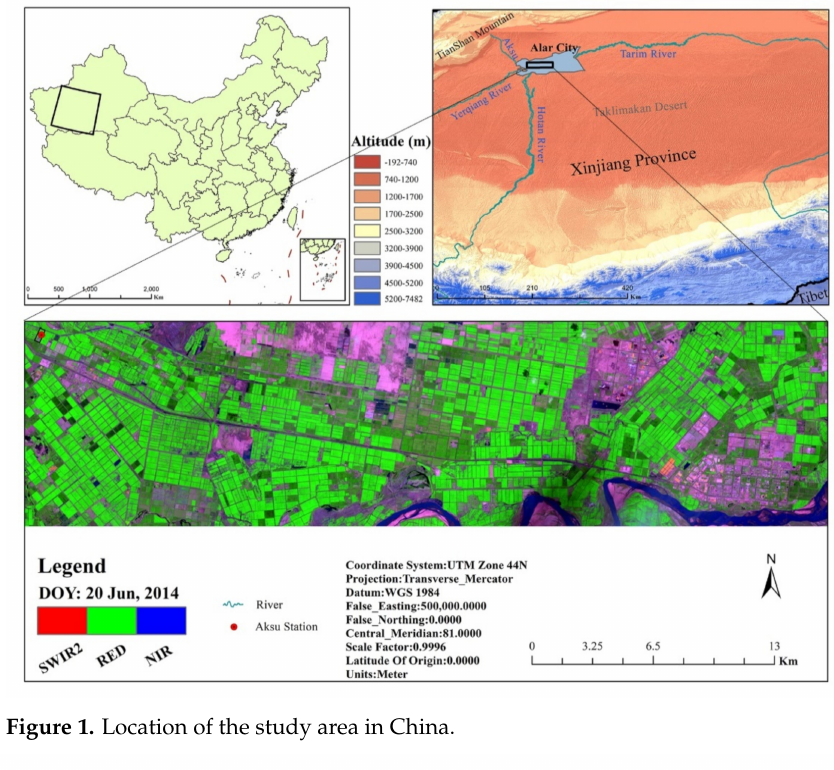
Figure 1. Location of the study area in China.